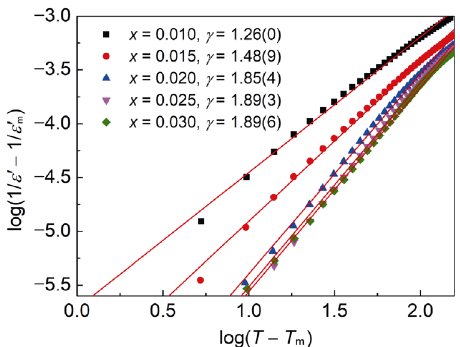
Fig. 6 Log(1/ ε ′ − 1/ ε ′ m ) as a function of log( T − T m ) of (1 − x )KNN– x BZN ceramics with different BZN contents at 1 MHz. The red lines show linear